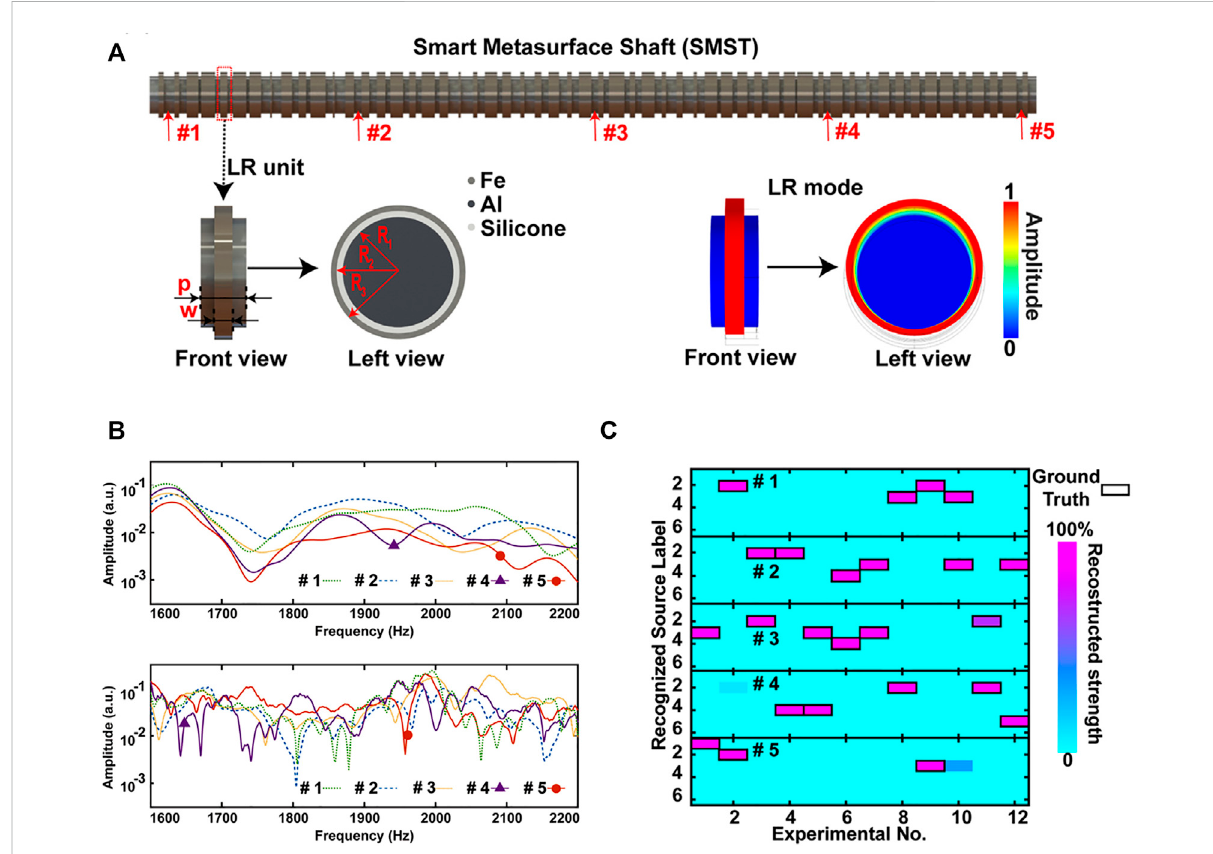
FIGURE 9 Smart metasurfaces shaft for vibration identi fi cation with a single sensor [76]. (A) Schematic diagram of the smart metasurface shaft. (B) The measured frequency responses without/with metasurface. (C) The reconstruction results for mechanical fault signals with a high recognition ratio. Figure reproduced with permission from: © 2020, Elsevier